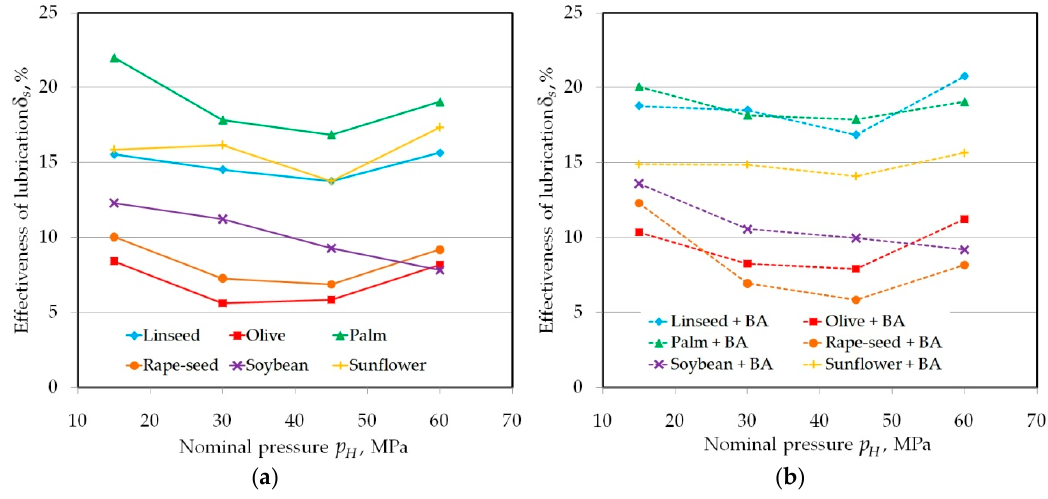
Figure 9. The effectiveness of lubrication using ( a ) pure vegetable oils and ( b ) vegetable oils with added BA in tests carried out under a range of nominal pressure between 15 and 60 MPa for a roll roughness of Ra = 1.25 m.